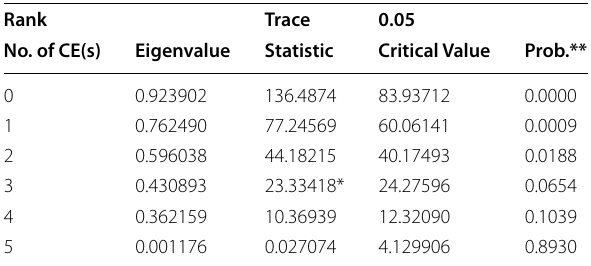
Table 4 Johannes cointegration tests